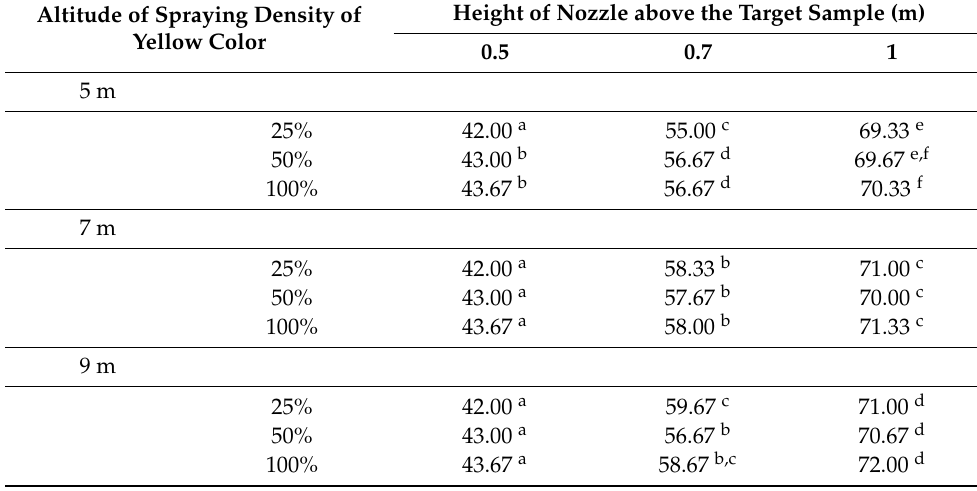
Table 3. Spraying footprint (diameter, cm) at different heights and the percentage of three sample color